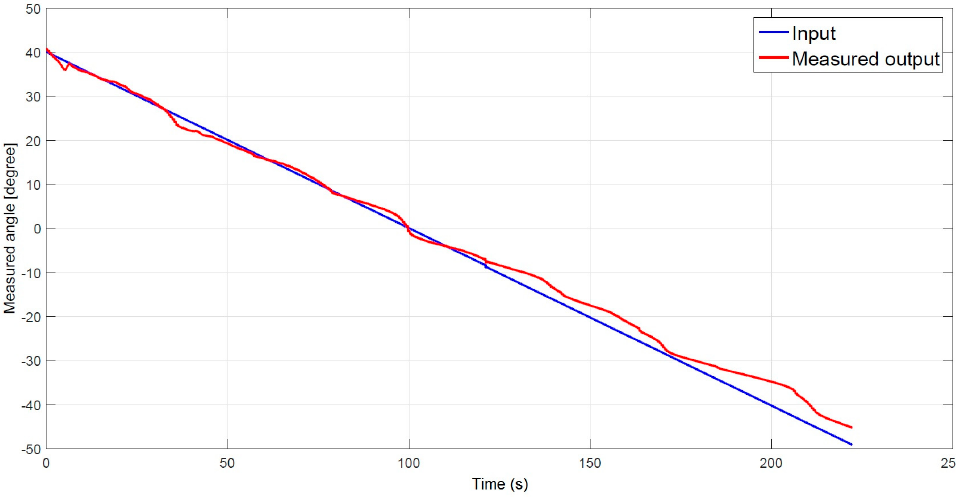
Figure 6. Open-loop measurement of a decreasing ramp.